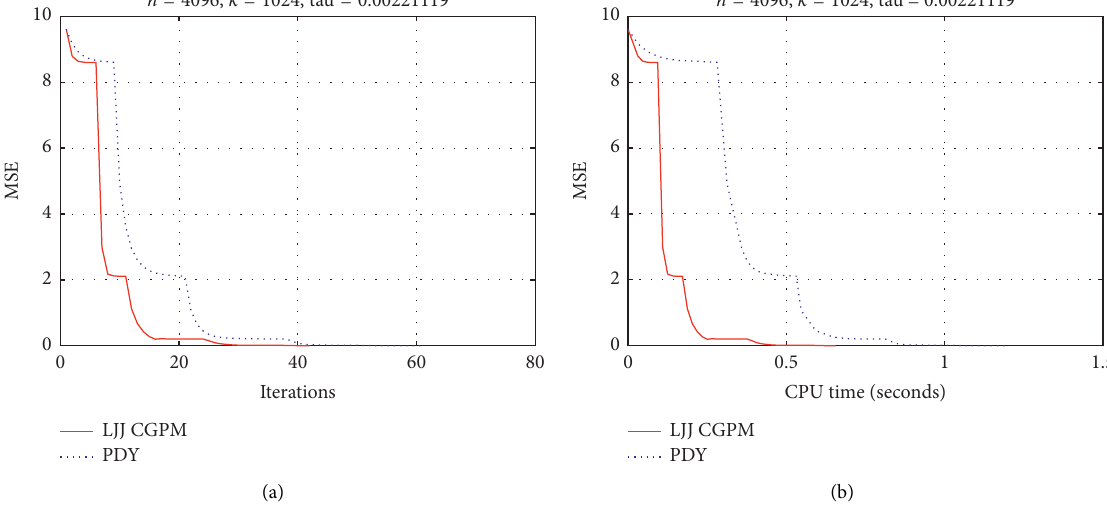
Figure 5: Plots of MSE versus iteration and CPU time.